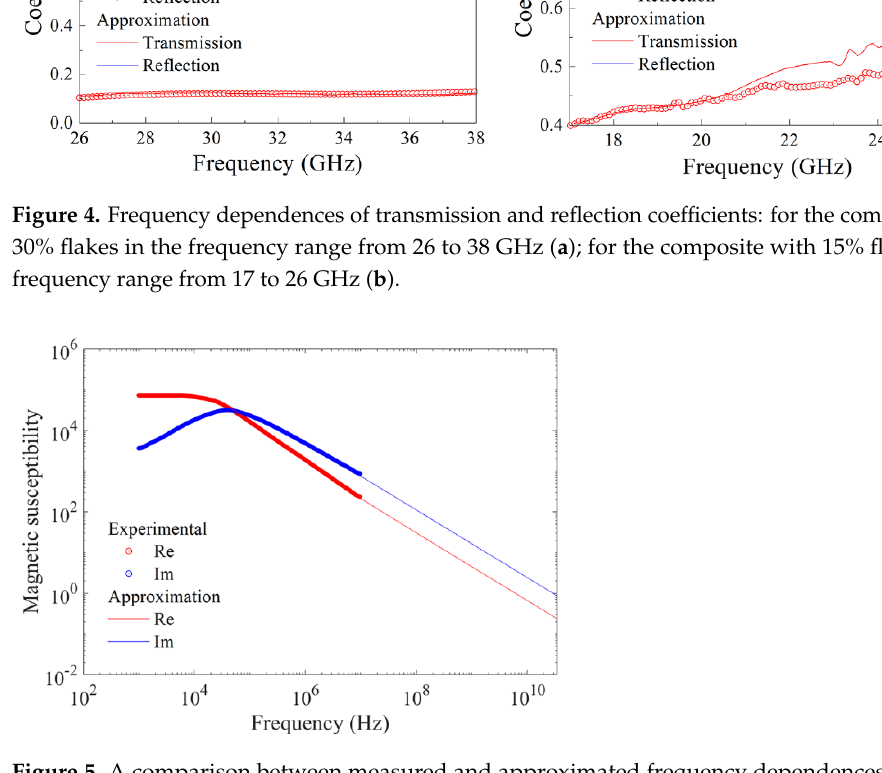
Figure 5. A comparison between measured and approximated frequency dependences of the real and the imaginary parts of magnetic permeability of Finemet alloy.